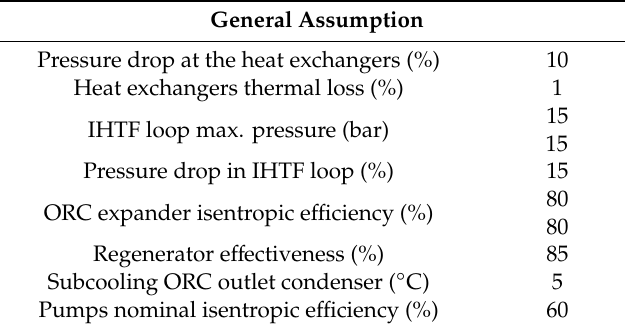
Table 5. ORC general assumptions.